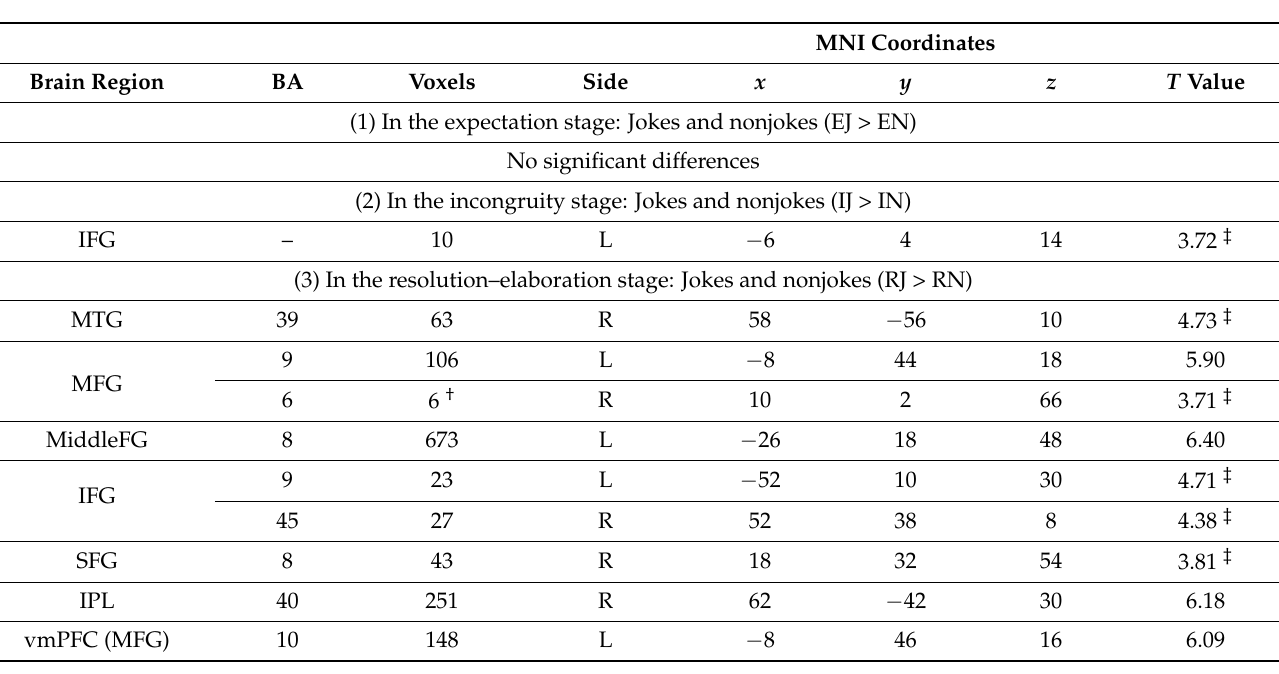
Table 5. Simple main effects of joke type under the expectation, incongruity, and resolution– elaboration